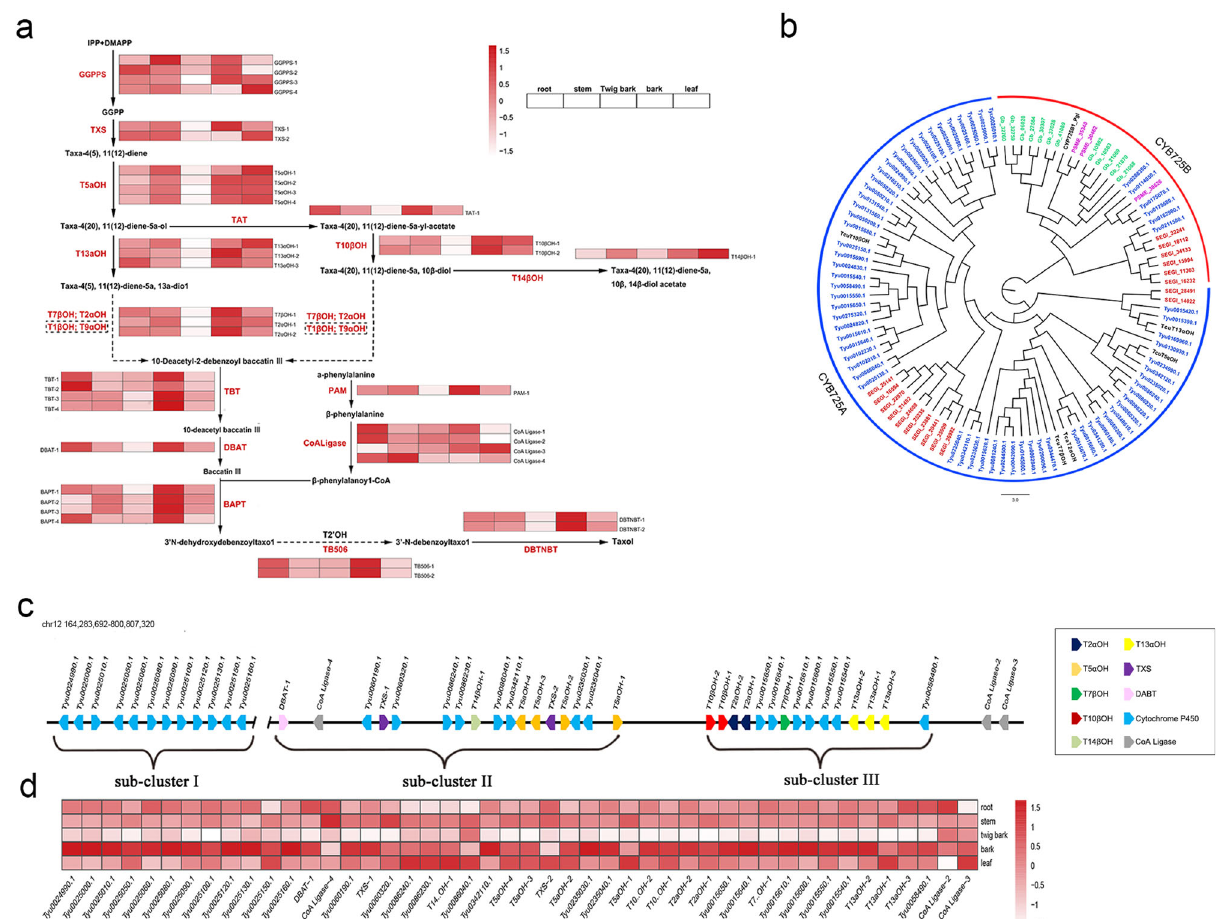
Fig. 3 Genes involved in the Taxol biosynthetic pathway. a Transcriptomic analysis of genes involved in the Taxol biosynthetic pathway. The FPKM was calculated to evaluate the expression level of each gene. T1 β OH and T9 α OH represent the enzymes responsible for C-1 and C-9 oxidation that are currently unveri fi ed and which are presumed to belong to CYP450 gene family. b Phylogenetic tree of the CYP725A gene sub-family in T. yunnanensis , S. giganteum , P. menziesii and G. biloba . Genes from the four different plants are labeled in different colors, Blue, T. yunnanensis ; Pink, P. menziesii ; Red, S. giganteum ; Green, G. biloba . c Arrangement and chromosomal positions of three Taxol gene clusters on chromosome 12 (chr12). d Heat maps of gene expression of CYP725A genes located on chromosome 12. The average expression pro fi les of three replicates of different tissues of T. yunnanensis were used to make the heat map. Color scale represents log2-transformed FPKM (expected number of fragments per kilobase of transcript sequence per millions base pairs sequenced) values. The gradual change of the color indicates the different expression levels of genes, white indicating low transcript abundance and red indicating high levels of transcript